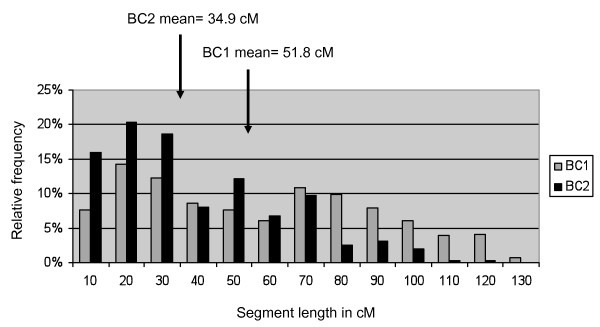
Distribution of donor segment lengths as calculated for both the BC1F1 and the BC2F2 generations derived from the cross between Fleur 11 cultivated variety and the synthetic amphidiploid AiAd.